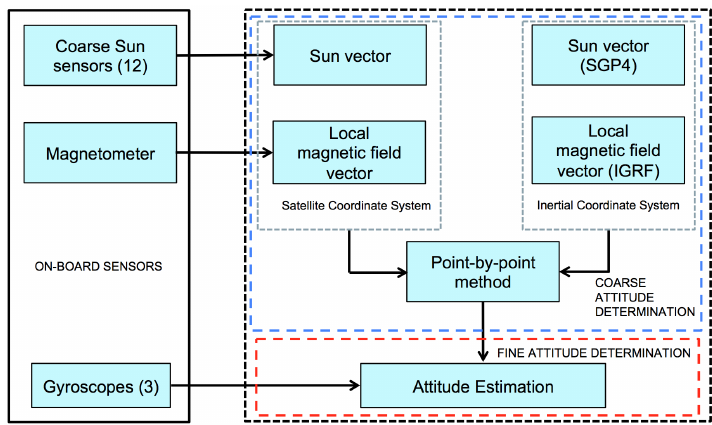
Figure 3. Attitude determination philosophy for the Ten-Koh satellite. The magnetometer instrument is used for space environment purposes as well as for